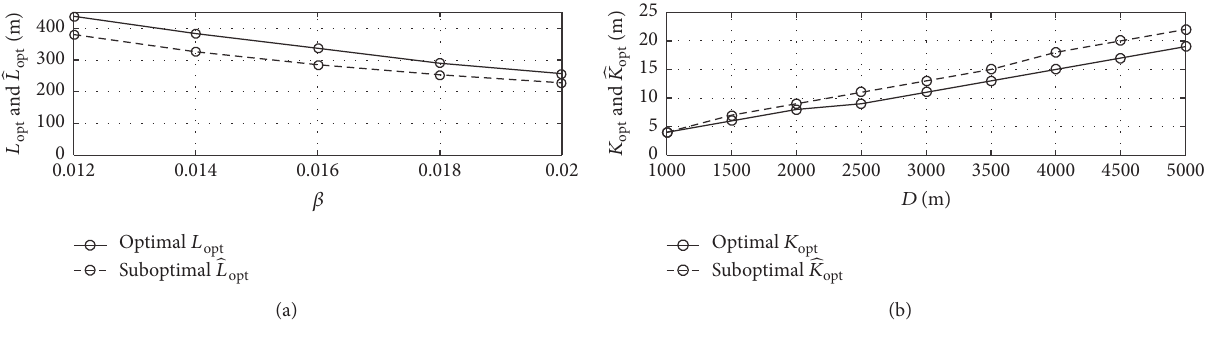
Figure 7: Optimal hop distance and hop count for 𝜆 = 0.003 and 𝑏 𝑘 = 4 : (a) 𝐿 opt versus 𝛽 and (b) 𝐾 opt versus 𝐷 , when 𝛽 = 0.02 .